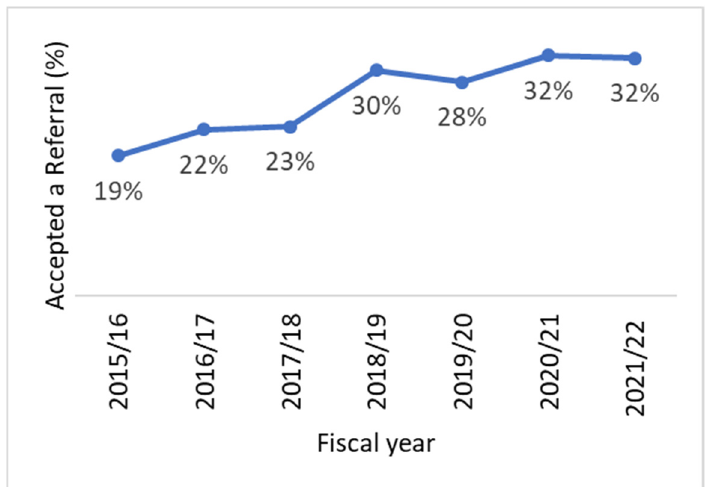
Figure 2. Acceptance of a referral rates among current and recent smokers in Ontario RCCs, by fiscal year, 2015–2016 to 2021–2022.